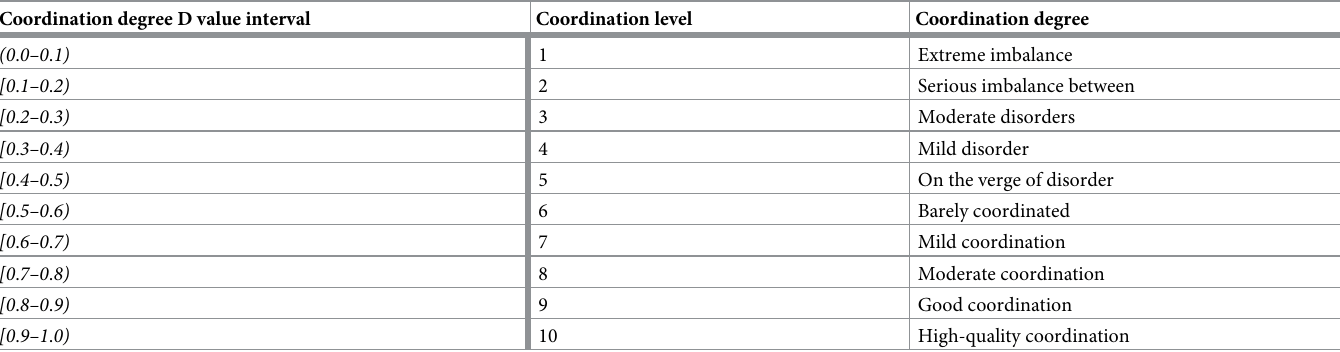
Table 5. Classification criteria of coupling coordination degree.